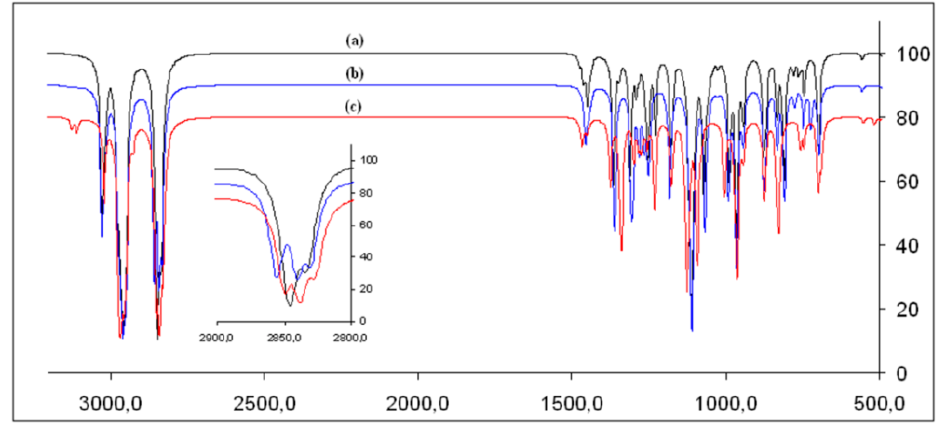
Figure 4. Calculated FT-IR spectra of: ( a ) C i conformer, ( b ) C 2v conformer, and ( c ) C 2 conformer at the B3LYP/6-31G(d,p) level of theory.